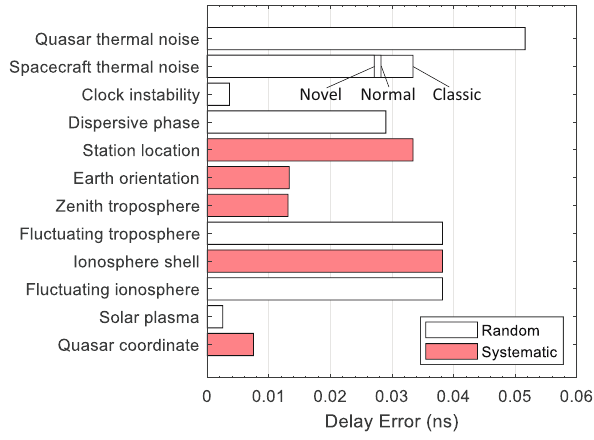
Figure 4: Error budget for Delta - DOR measurements of three types of